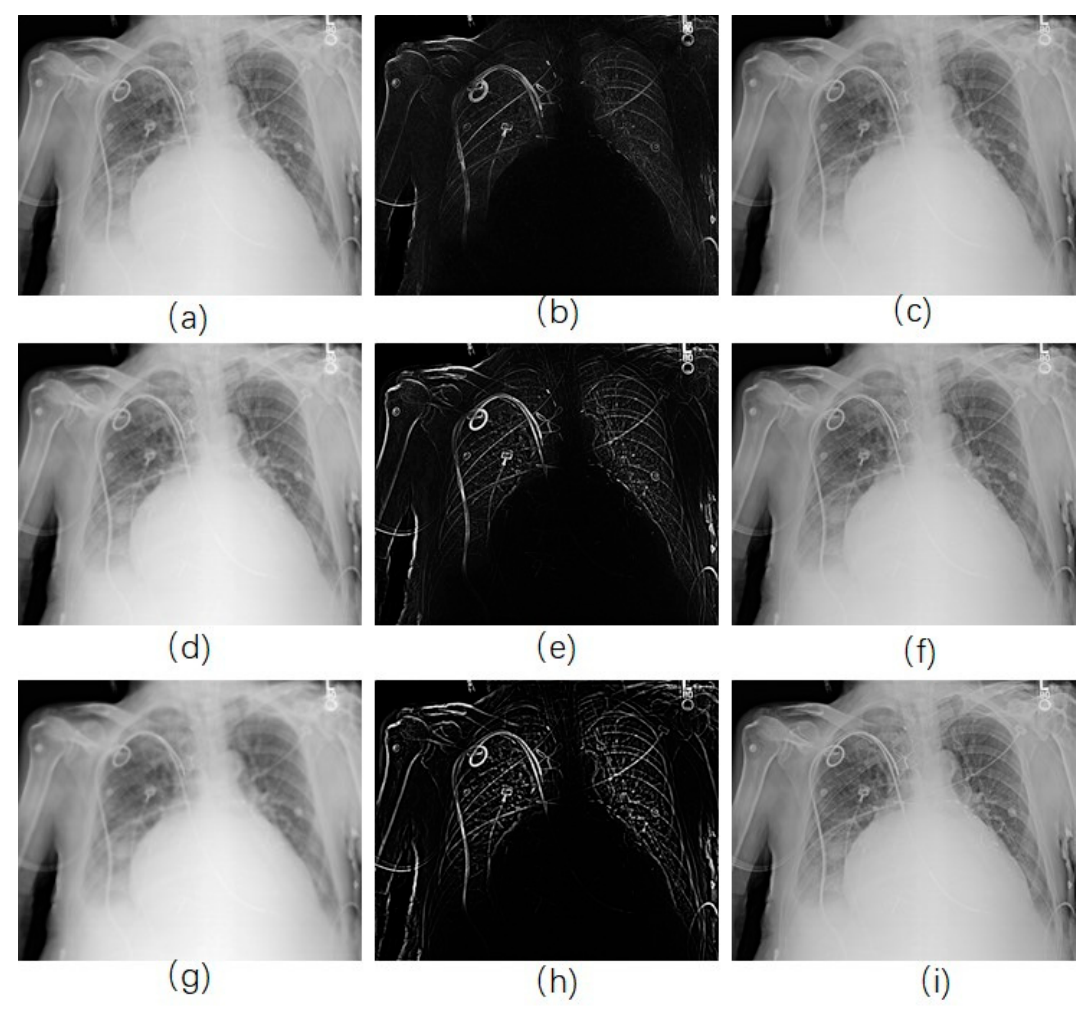
Figure 5. CXR enhancement by use of reverse anisotropic di ff usion (RAD) -based USM. ( a , d , g ) were the smoothed images with di ff usion parameter 0.001, 0.02, 0.2, respectively; ( b , e , h ) were the corresponding unsharp masks to ( a , d , g ); ( c , f , i ) were the corresponding enhanced images.